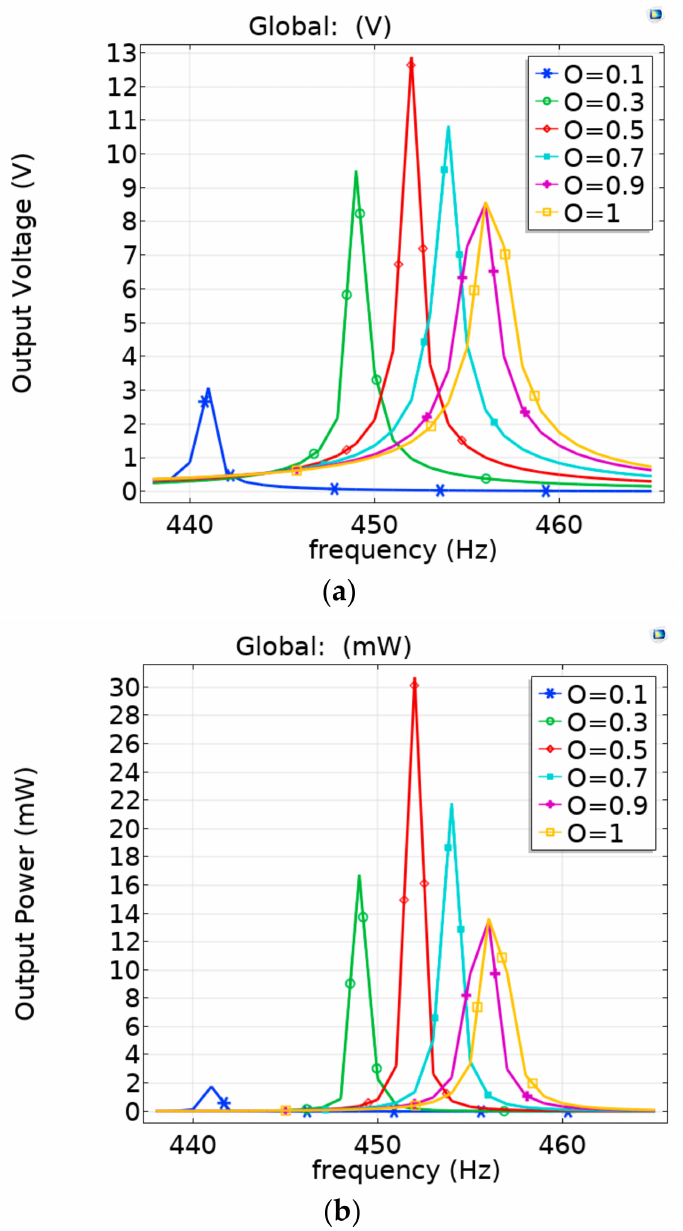
Figure 7. Frequency response of generated output voltage ( a ) and output power ( b ) at the second vi- bration mode for different tapering ratios of the segmented PVEH for a mechanical input acceleration of 0.5